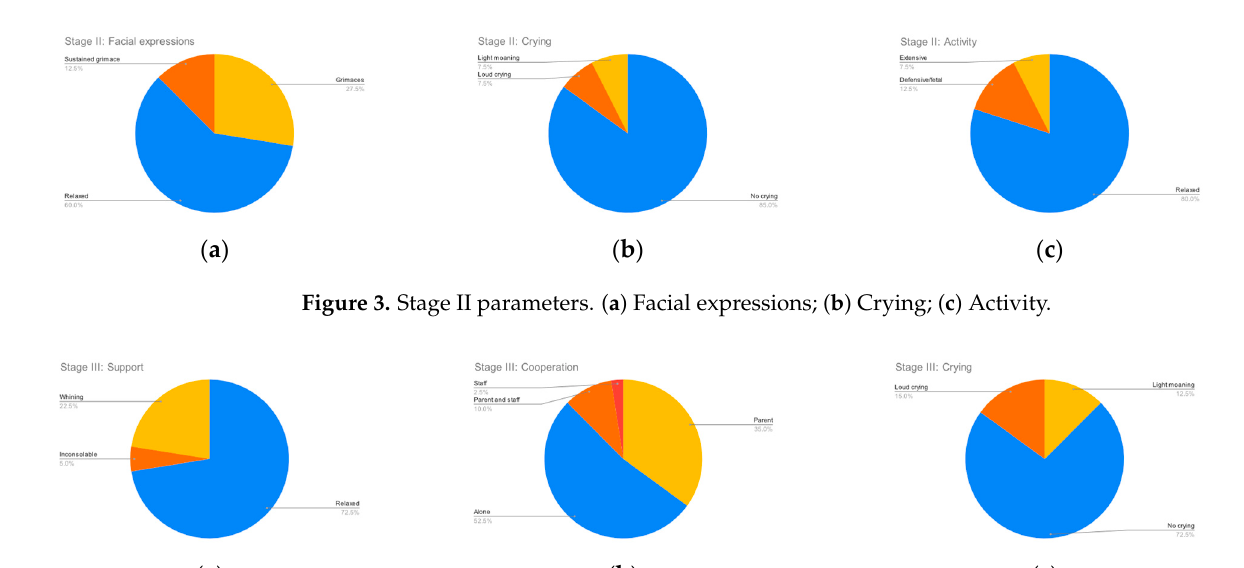
Figure 2. Stage I parameters. ( a ) Hesitation; ( b ) Crying.